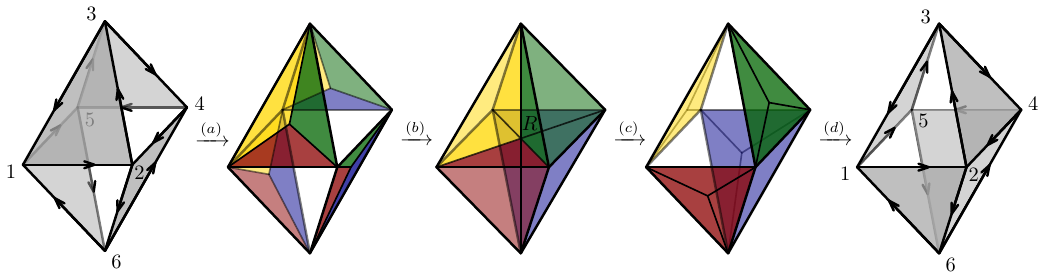
Figure 2 . Sphere move for the octahedron. (a) Start with T = f (1 ; 2 ; 3) ; (3 ; 4 ; 5) ; (5 ; 6 ; 1) ; (6 ; 4 ; 2) g and subdivide each triangle (cid:1) abc with a reference point (for clarity we remove orientations from the edges). (b) Move all four reference points into the common point R . (c) Open up the triangles into a di(cid:11)erent set of (shaded) triangles. (d) Remove the reference points to obtain the leading singularity associated to T = f (2 ; 3 ; 4) ; (4 ; 5 ; 6) ; (6 ; 1 ; 2) ; (1 ; 5 ; 3) g .